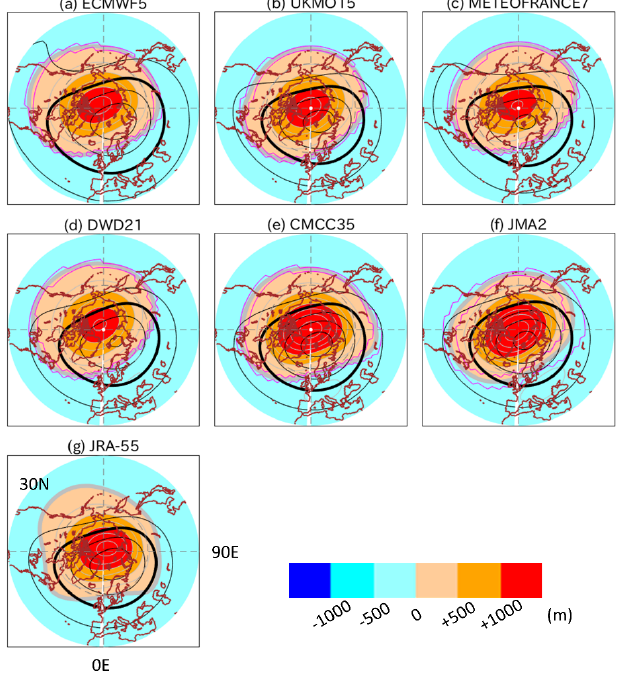
Figure 5. This is the same as Figure 4, but using the 10 hPa GPH from lag = −2 to +2 days. ( a – g ) All wave number components in addition to the zonal mean are retained. Contour interval is 250 m for the anomalies, and 500 m for the climatology. Thick black contour denotes 30,000 m.